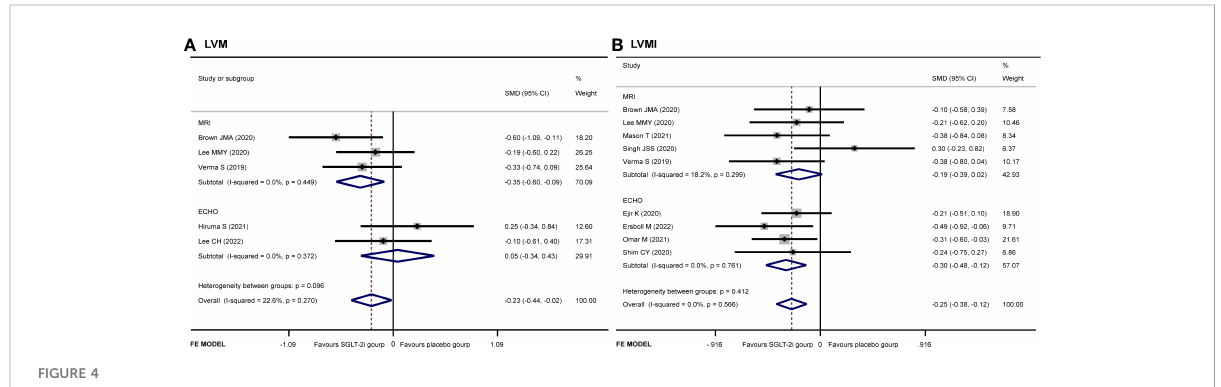
FIGURE 4 Subgroup analysis of (A) LVM and (B)